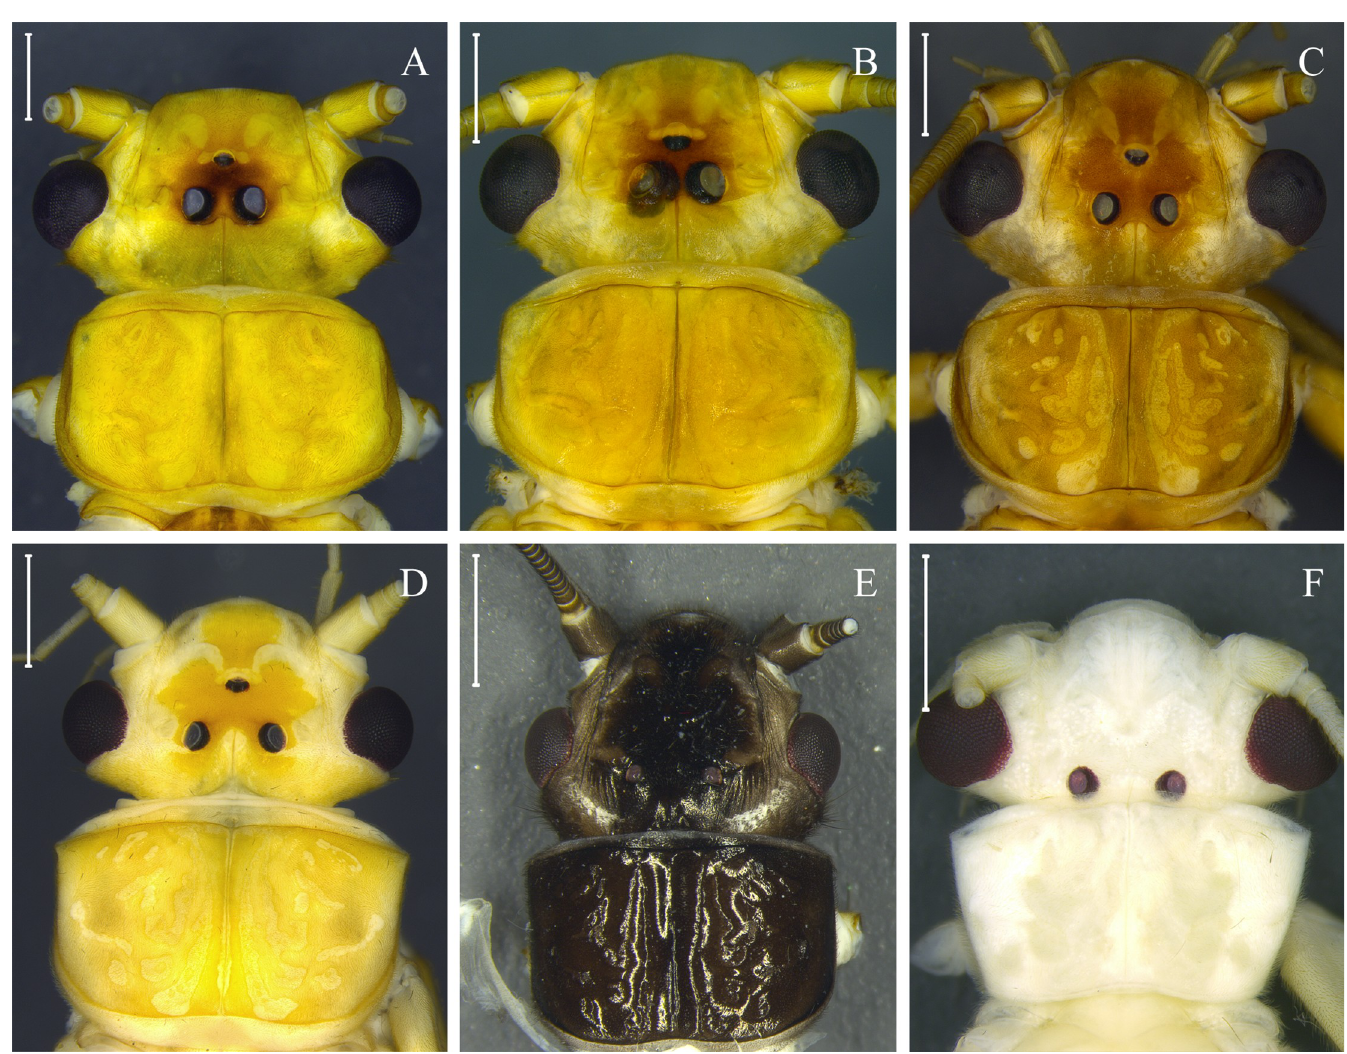
Fig 10. Kempnyia and Macrogynoplax species. Head and pronotum of a K . colossica adult male from the Paranapiacaba Mountains (A), PR (B) and SC (C), a K . flava adult female (D), a K . sp. adult female (E) and an M . veneranda adult male (F). Scale: 1